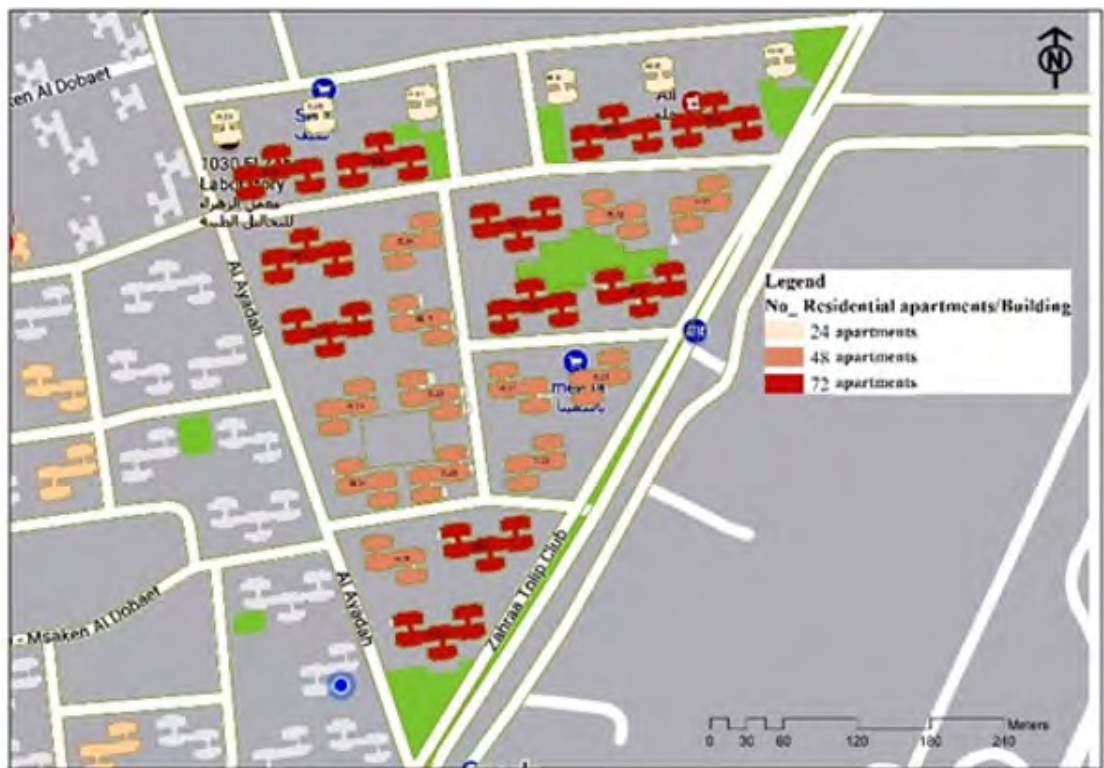
Figure 15. No of Residential Apartments in each building